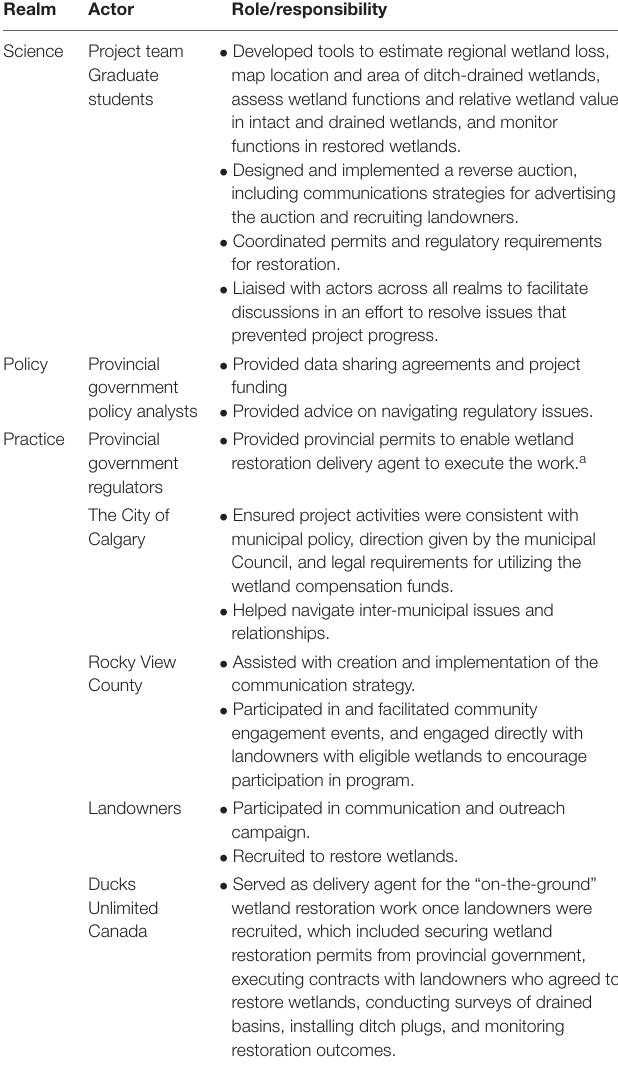
TABLE 3 | Actors within the science, policy, and practice realms involved in the living laboratory project. Realm